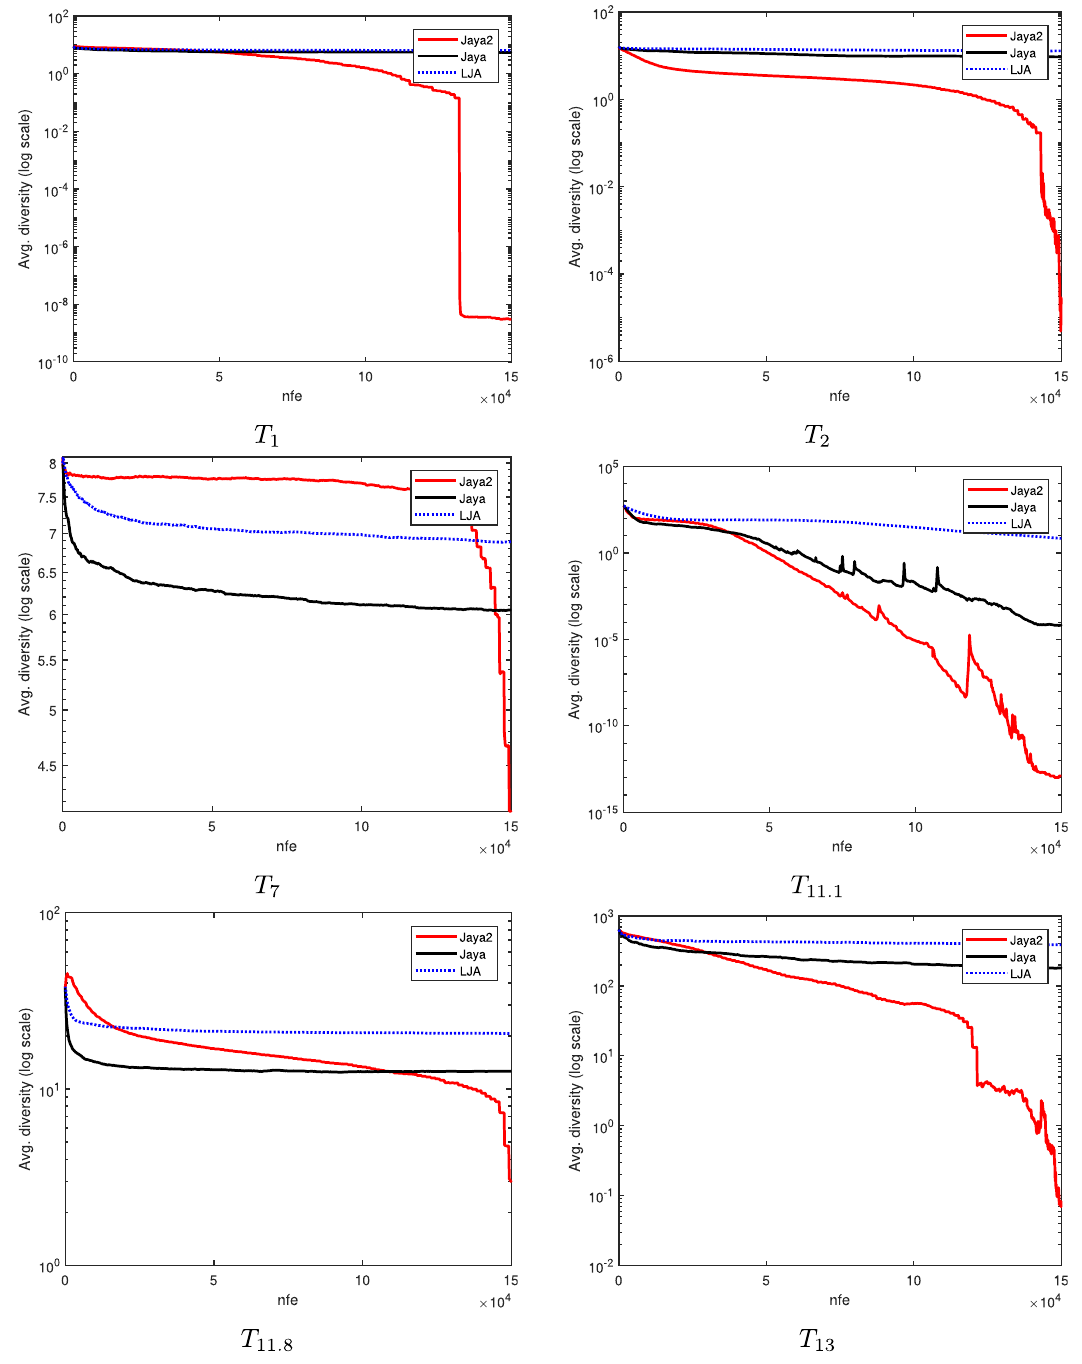
Figure 7: Diversity curves ( averaged across 25 runs ) of Jaya2, Jaya, and LJA for selected CEC 2011 real - world